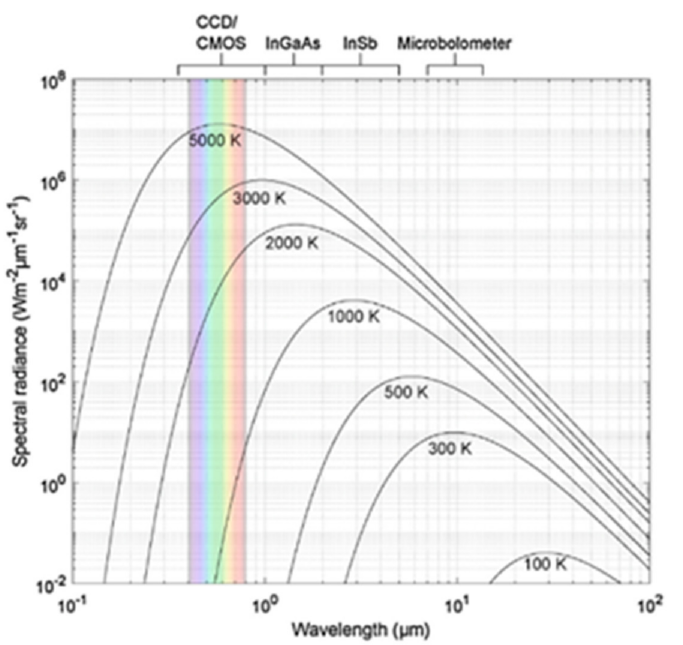
Figure 6. Spectral radiance of a blackbody at various temperatures. Wavelength sensitivity ranges for various detectors are indicated above